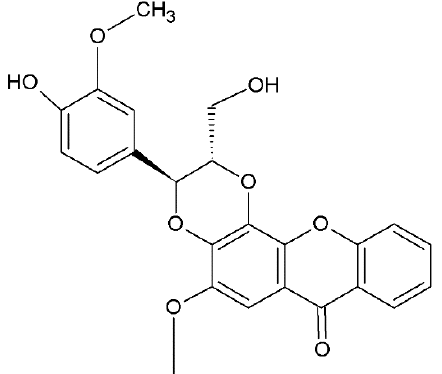
Figure 6. Structure of kielcorin, xantholignoid.